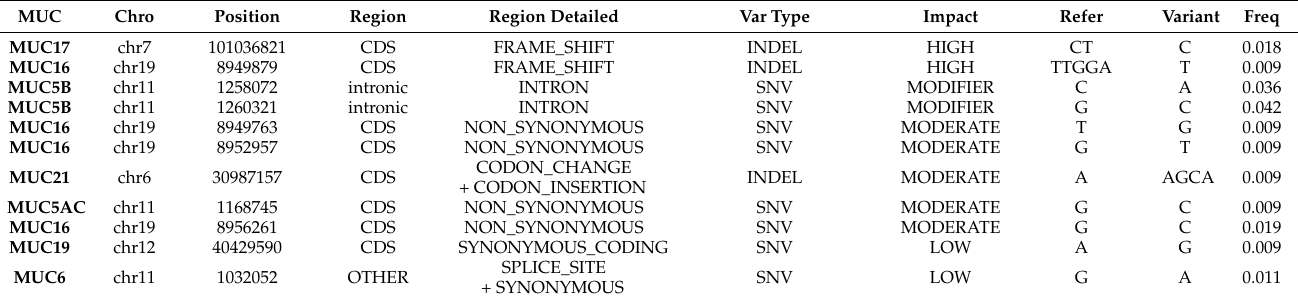
Table 2. New variants found in healthy indigenous